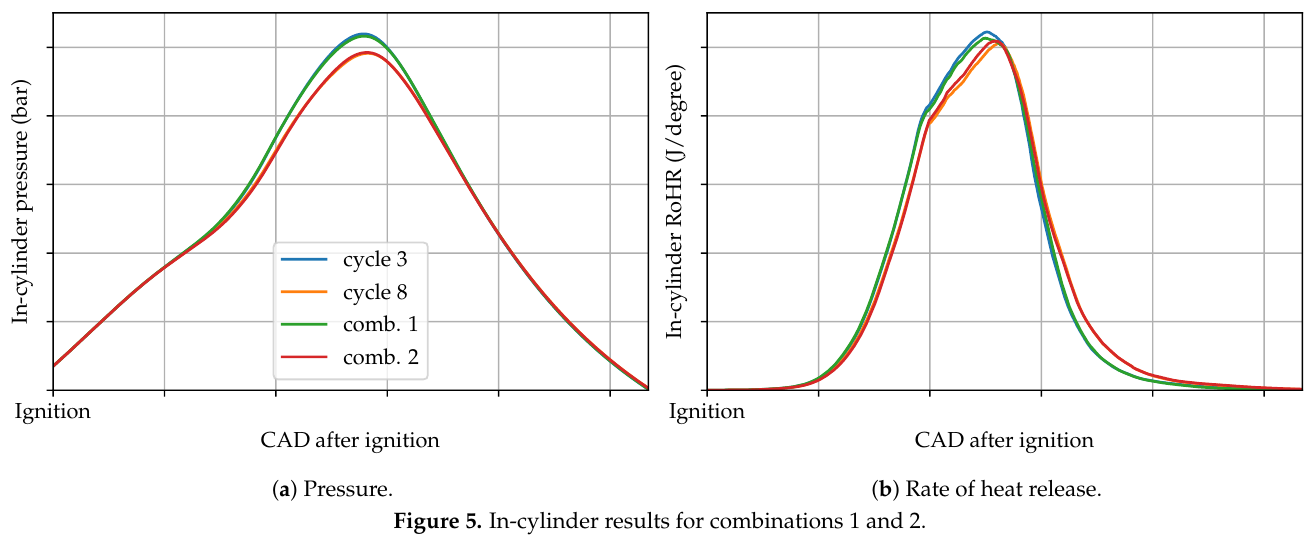
Figure 5. In-cylinder results for combinations 1 and